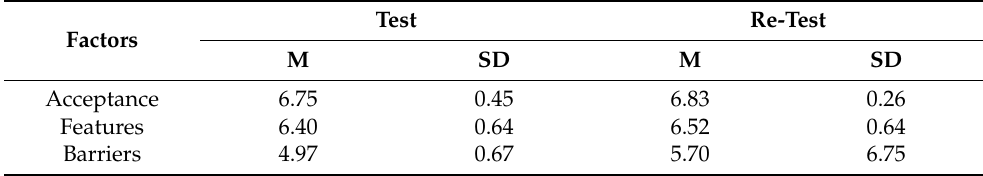
Table 3. Descriptive statistics for the